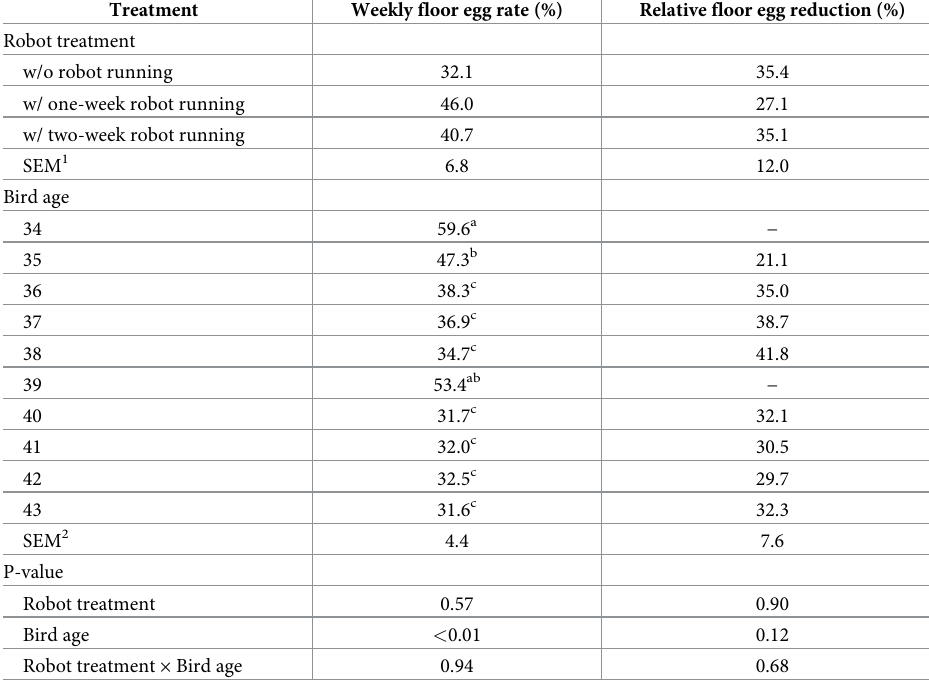
Table 1. Weekly floor egg rates and relative floor egg reduction. Treatment Weekly floor egg rate (%) Relative floor egg reduction (%) Robot